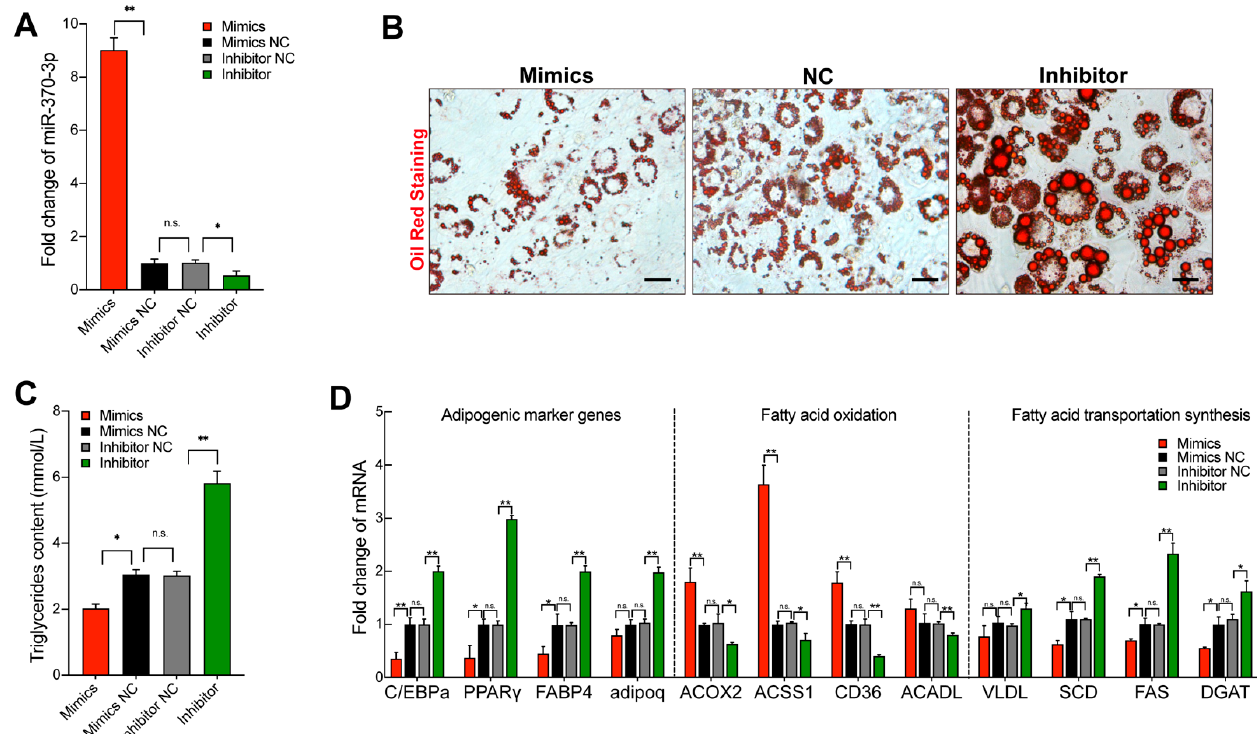
Figure 3. miR-370-3p inhibits preadipocyte differentiation. The transfection efficiency of transfection with miR-143-3p mimics or inhibitors in 3T3-L1 cells cultured in differentiation medium. ( A )The transfection efficiency in 3T3-L1 cells of miR-370-3p. ( B ) Oil Red O staining, ( C ) triglycerides content, and ( D ) the expression of marker genes related to adipogenic, fatty acid oxidation, and fatty acid transportation synthesis. Scale bars 50 μ m. All results are presented as means ± SEM. n = 3 per treatment. Each treatment represents the mean of three replicates. * p < 0.05; ** p < 0.01, n.s. no significant differ-ence.